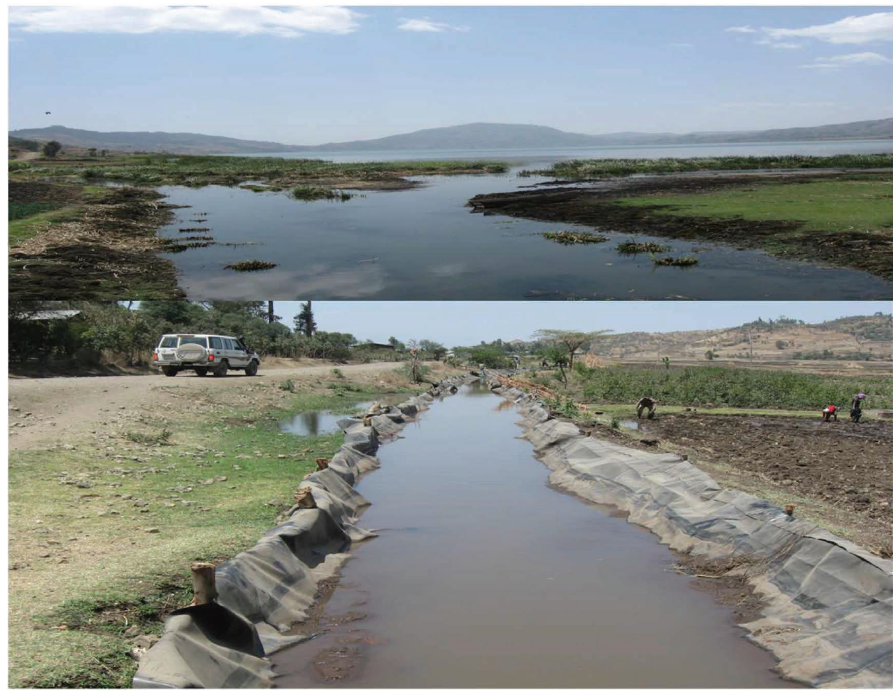
Figure 2: Excessive water abstraction of Lake Ardibo, fooding irrigation for chat ( Catha edulis ) farming (source: own picture).